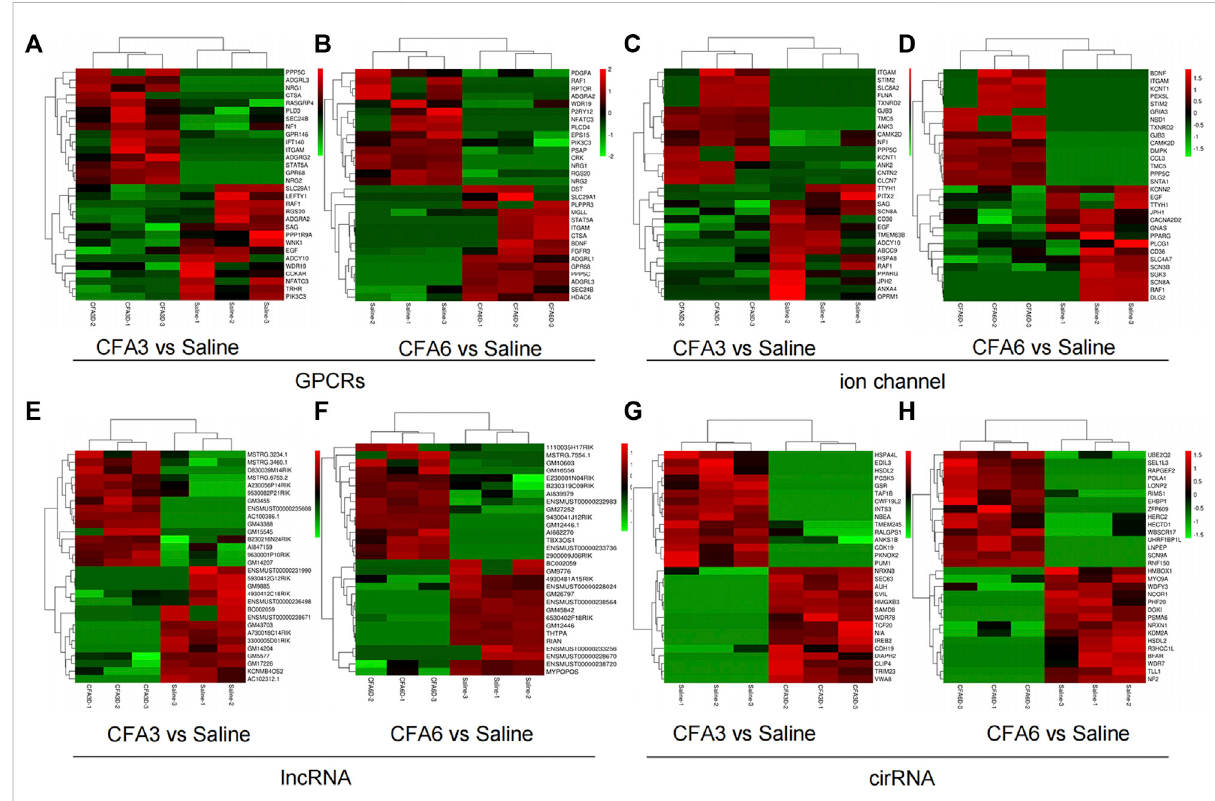
FIGURE 4 Heatmaps of the representative differentially expressed genes (DEGs) in the TG of TMD mice (A – C) . Top 15 upregulated and downregulated genes of G protein-coupled receptors (A,B) , ion channels (C,D) , long noncoding RNAs (lncRNAs) (E,F) , and circular RNAs (cirRNAs) (G,H) in the TG after CFA injection on day 3 (A,C,E,G) and on day 6 (B,D,F,H) . Colors in the heatmaps indicate the row Z-score among the different datasets. The upregulated and downregulated genes are colored in red and green, respectively. n = 9